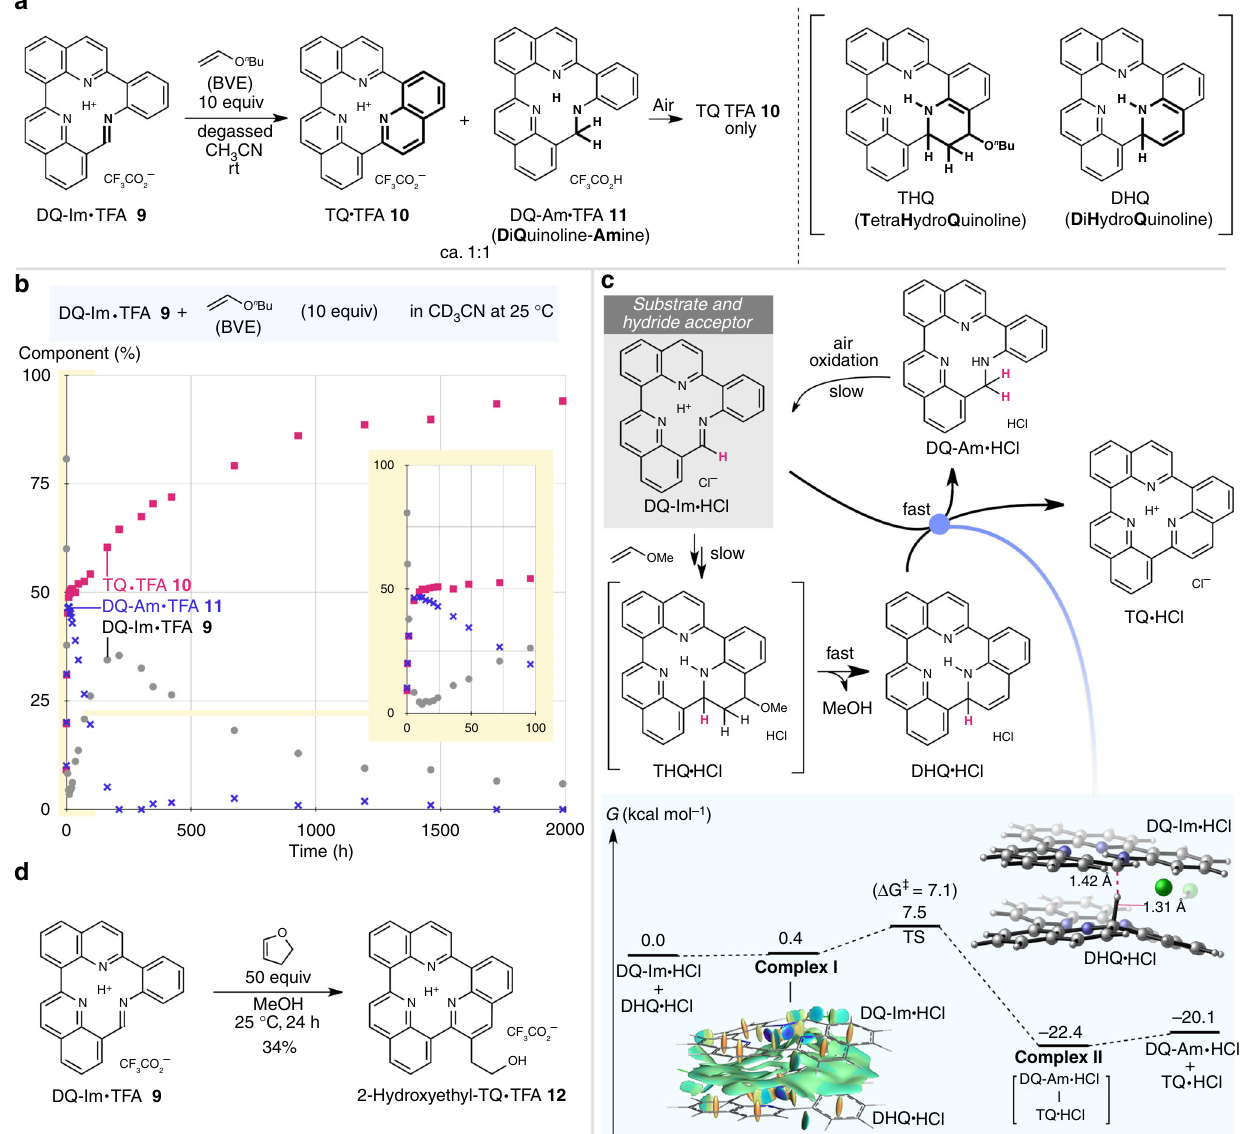
Fig. 3 An unusual non-stop Povarov reaction allows the one-pot construction of the quinoline unit en route to TQ. a Evaluation of the unusual Povarov reaction of DQ-Im (cid:129) TFA 9 and BVE under degassed conditions, affording a ca. 1:1 mixture of TQ (cid:129) TFA 10 and DQ-Am (cid:129) TFA 11 . Tetrahydroquinoline (THQ) or 1,2-dihydroquinoline (DHQ) intermediates were not detected. b Reaction pro fi le of DQ-Im (cid:129) TFA (1 equiv) and BVE (10 equiv) in CD 3 CN monitored at room temperature by 1 H NMR analysis. Inset: early stage of the reaction (0 – 100 h). c Plausible reaction mechanism based on the model reaction of DQ-Im (cid:129) HCl and methyl vinyl ether calculated at the ω B97XD/def2-TZVPP/SMD(acetonitrile)//B3LYP-D3/6-31G(d) level of theory. The energy diagram of the hydride transfer step is shown. The full energy landscape of the sequential reactions is provided in Supplementary Fig. 50. Non-covalent interactions visualised by the NCIPLOT programme. The blue and green areas denote strong and weak attractive interactions, respectively. d Synthesis of TQ derivative 12 with a 2- hydroxyethyl tail. BVE n -butyl vinyl